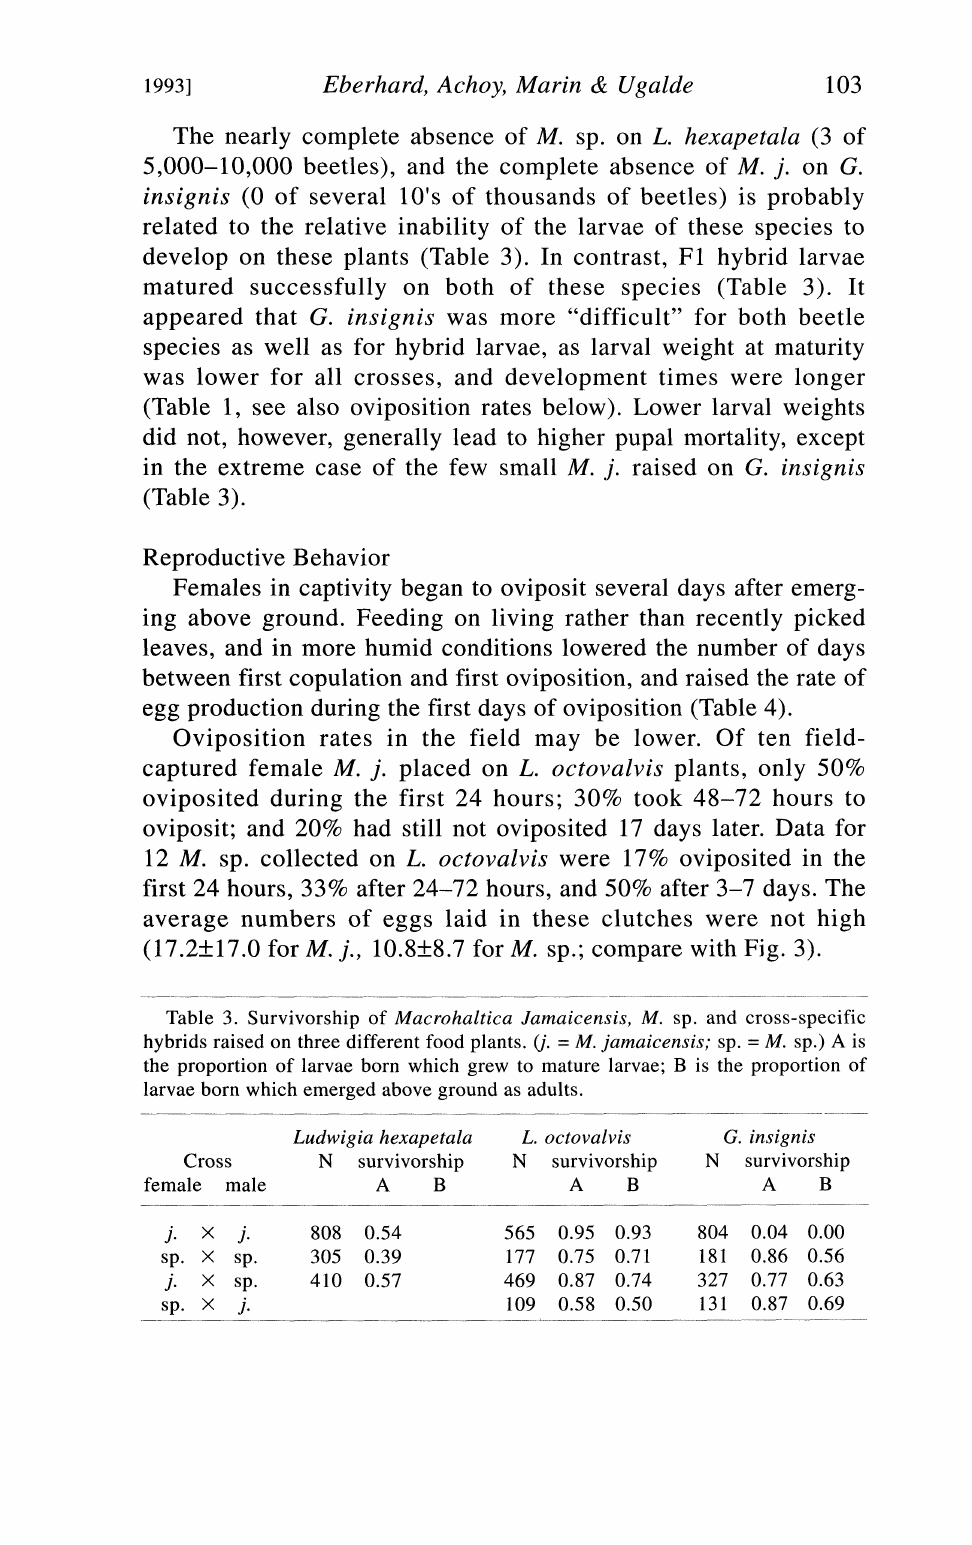
Table 3. Survivorship of Macrohaltica Jamaicensis, M. sp. and cross-specific hybrids raised on three different food plants. (j. M. jamaicensis; sp. M. sp.) A is the proportion of larvae born which grew to mature larvae; B is the proportion of larvae born which emerged above ground as